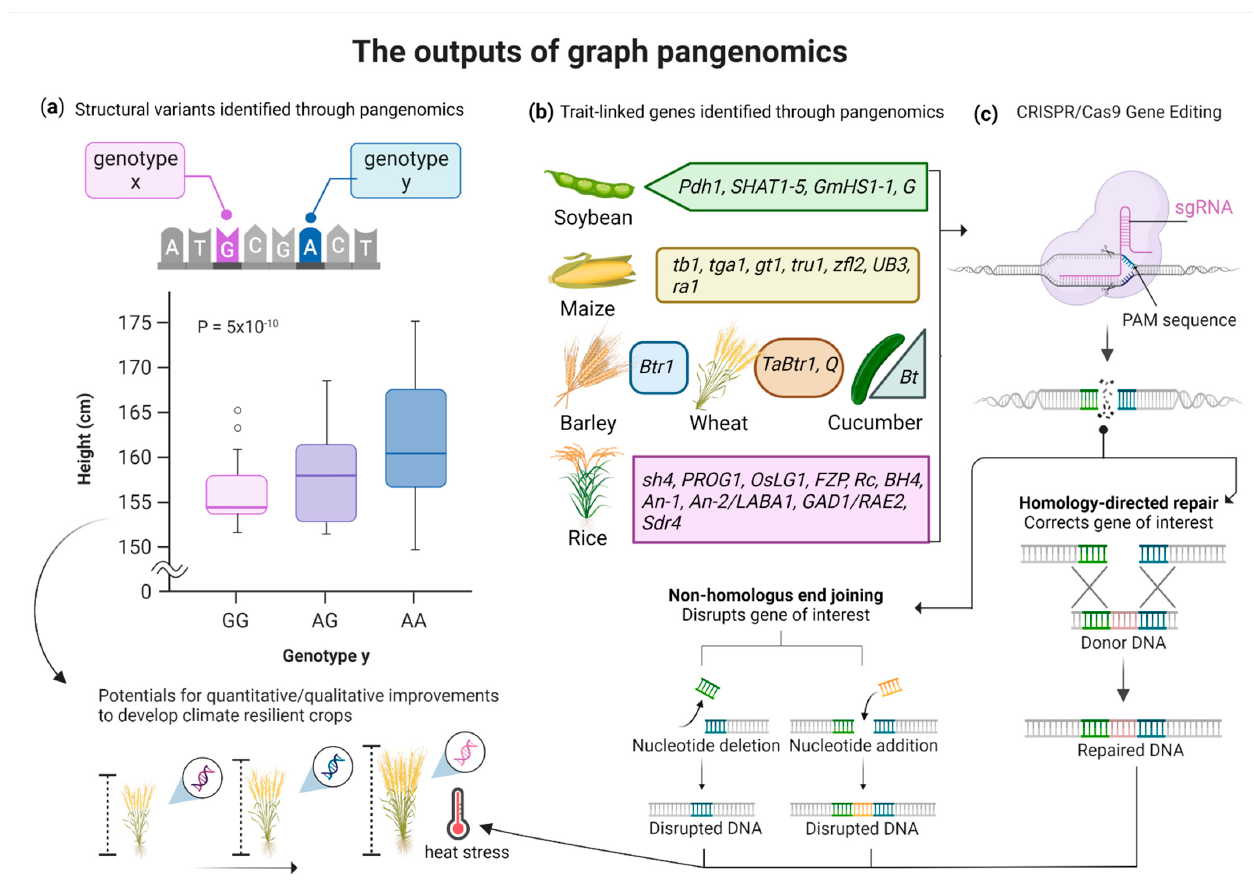
Figure 2. Schematic illustration of graph pangenomics outputs for crop improvements. ( a ) The analyzed datasets of graph pangenomes help identify structural variants among different genotypes that could be integrated after MAS into crops for trait improvements; ( b ) pangenomics identified trait-linked genes in different crops (adapted from [3]); ( c ) the identified gene targets could be used for fast-breeding using the CRISPR/Cas toolbox. This may bring desirable site-specific edits either through homology-directed repair or by introducing double-stranded breaks and subsequent cell DNA repair mechanisms, or by natural but the most time-consuming introgression breeding. Altogether, the identified traits or gene-edited plants may be developed to cope with ongoing climate change stress, such as temperature